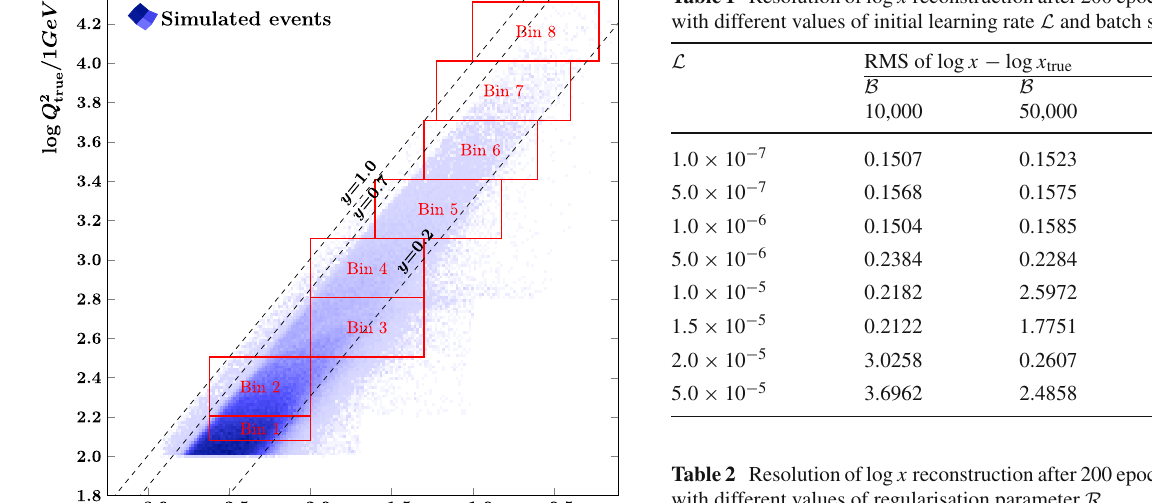
Fig. 3 Distributionofeventsfromthetrainingsetin ( x true , Q 2 and the boundaries of the analysis bins from Table 3